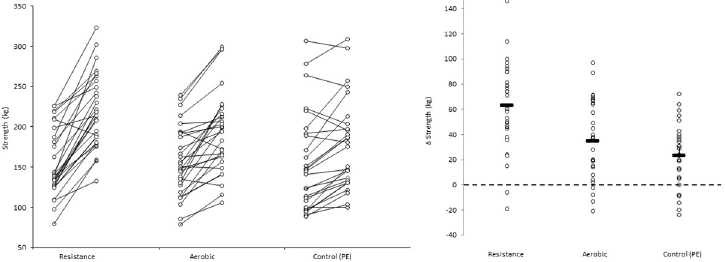
Fig 3. Left panel: Strength (kg) values pre- and post-intervention for each participant, and group means. Individual values and mean for within-group difference in strength Right panel:Individual participant and mean within-group post-intervention strength difference (kg). Pairwise effect sizes for within-group difference: Resistance; d = 1.2, aerobic; d = 0.58, PE (control); d = 0.32.